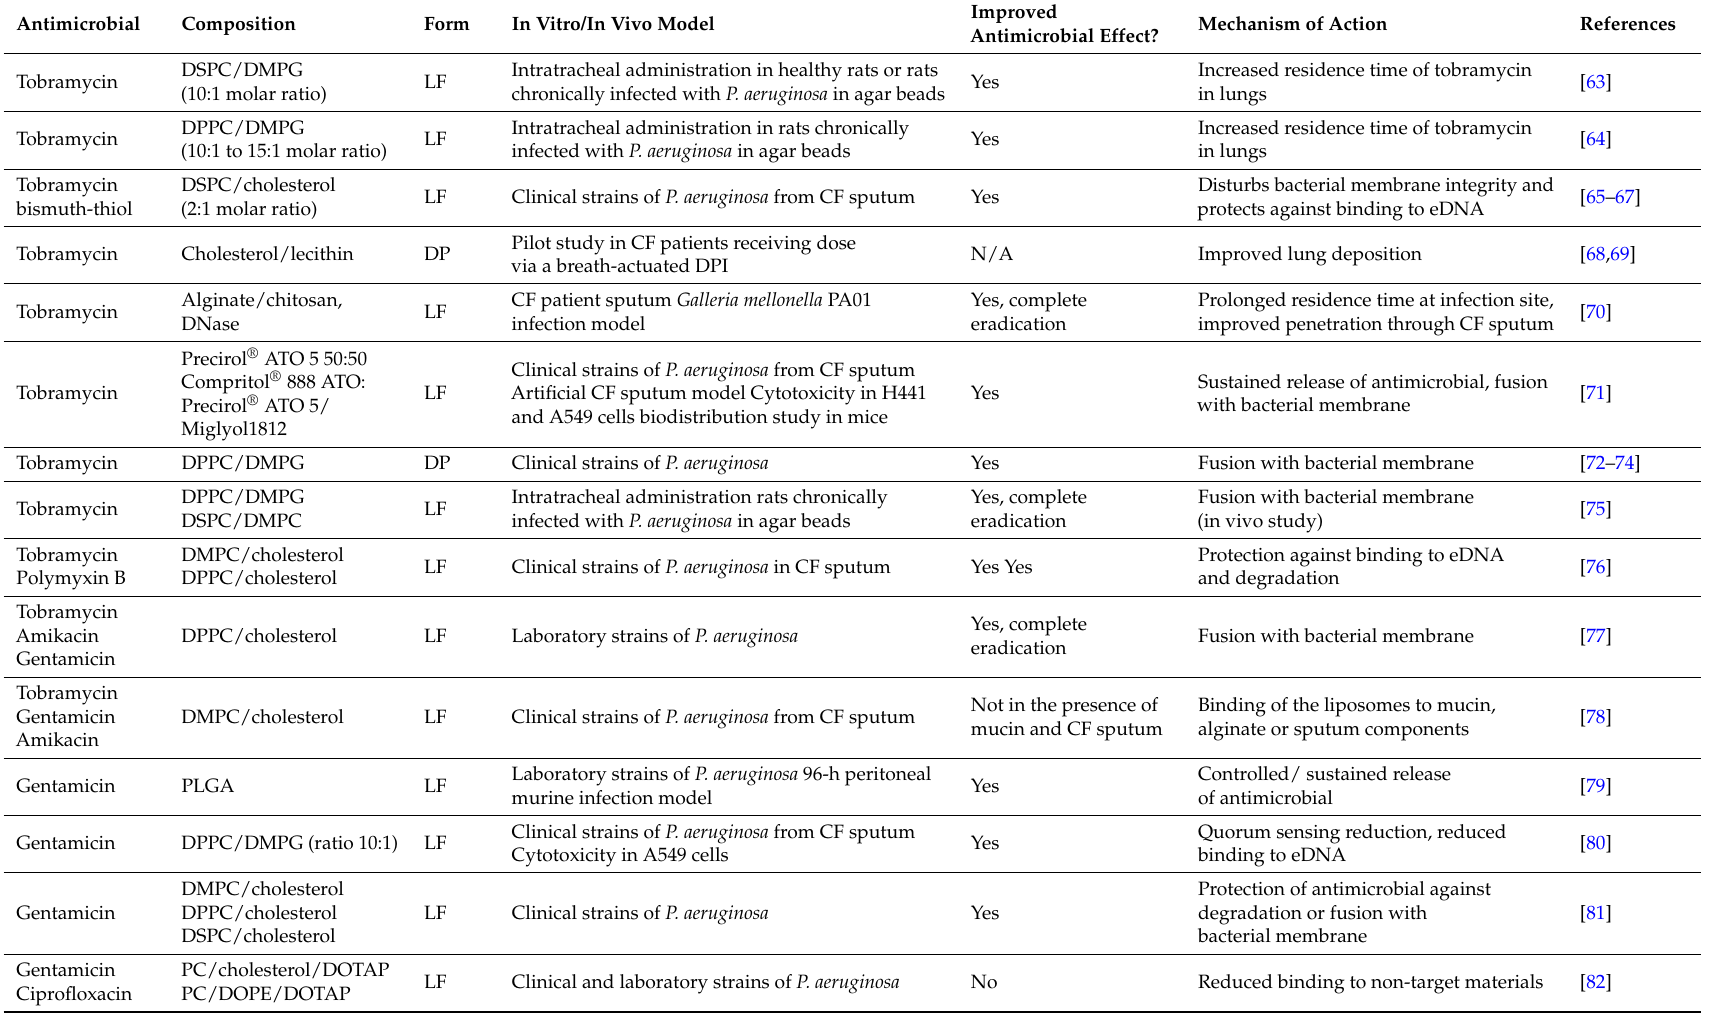
Table 2. Examples of lipid and polymeric antimicrobial formulations under development for P. aeruginosa